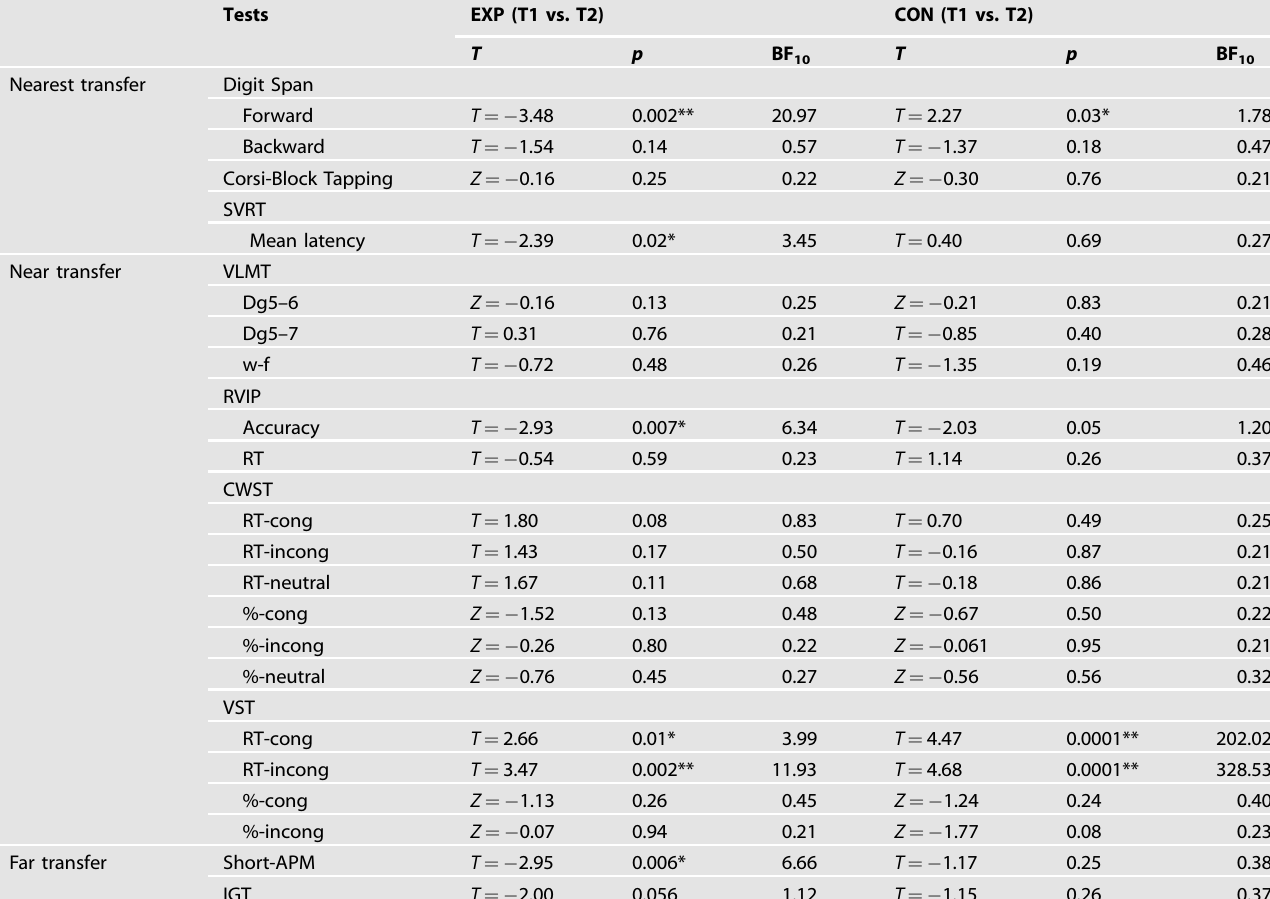
Table 3. Comparisons within each group for all cognitive